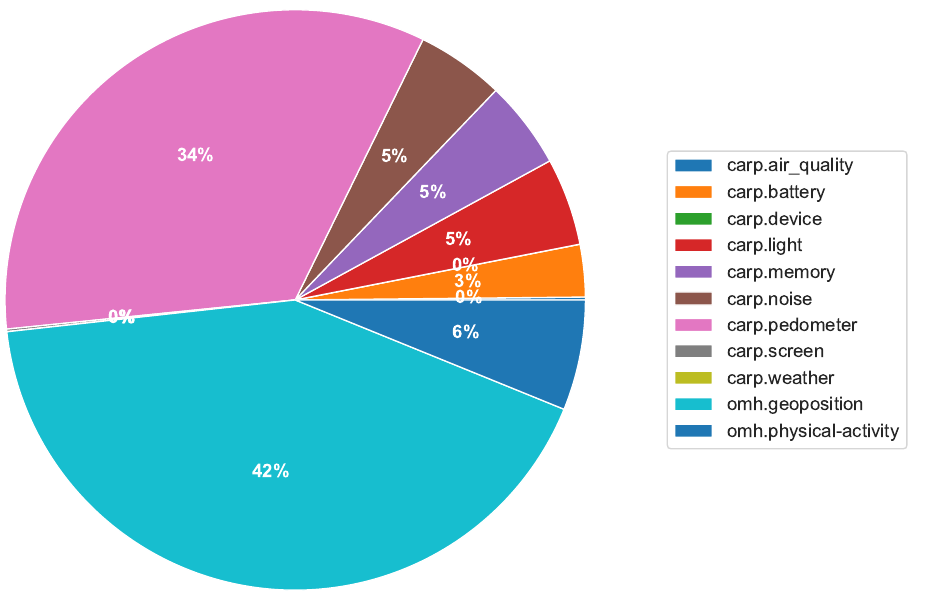
Figure 9. Distribution of collected